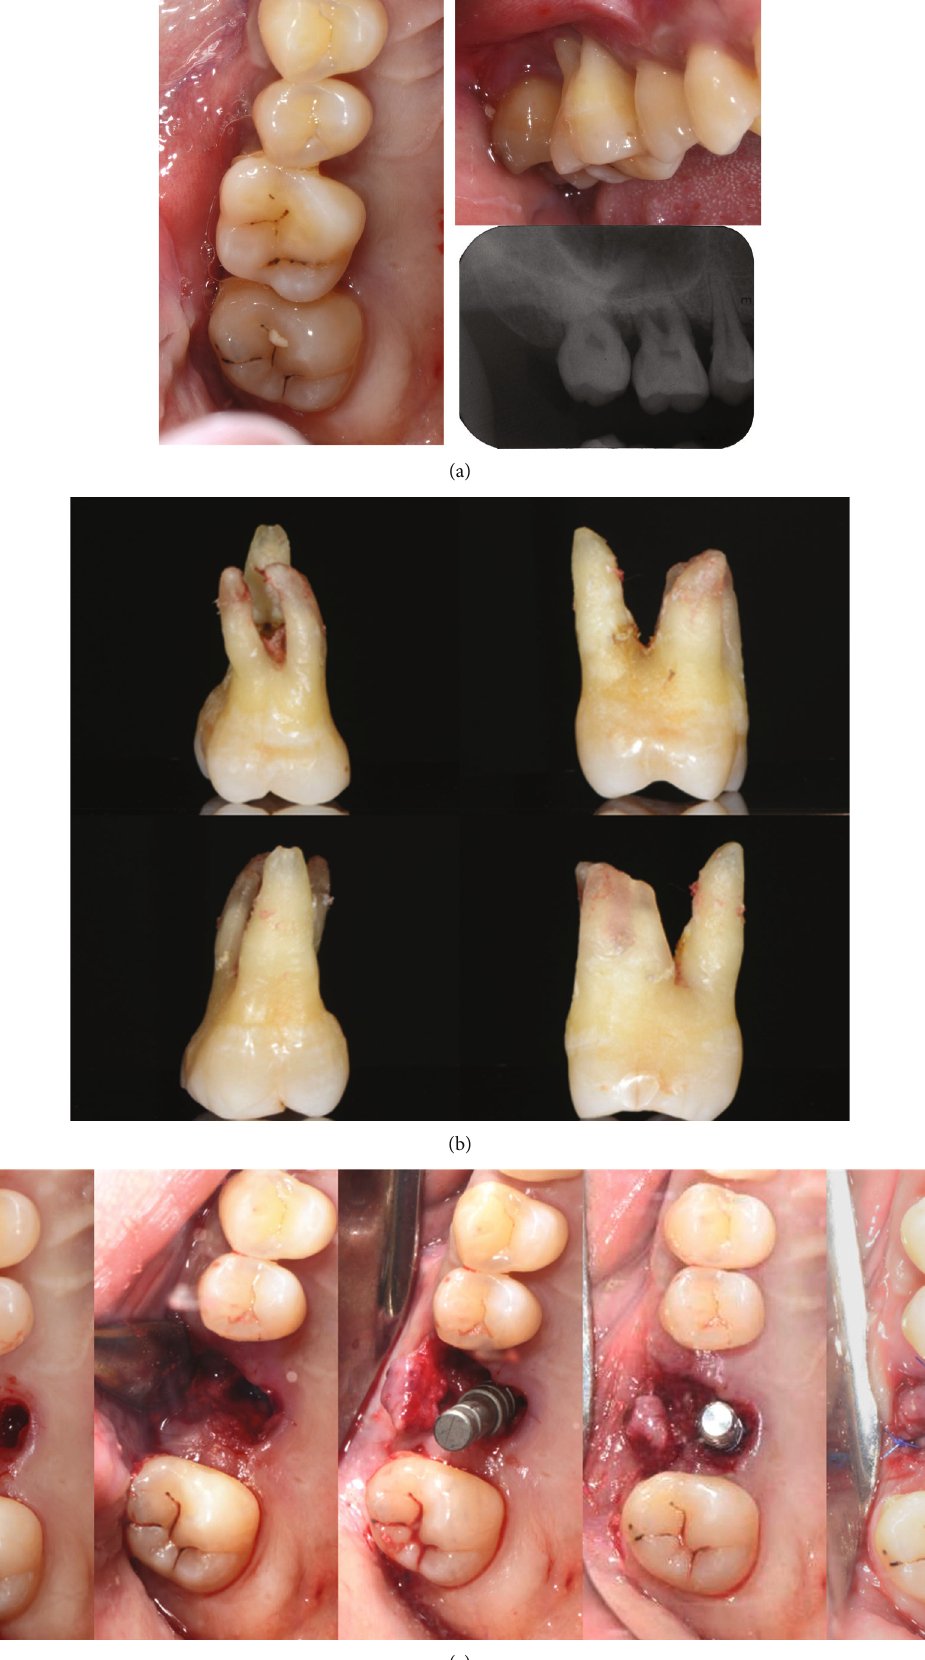
Figure 5: The process of implant placement. (a) Before the extraction. (b) The extracted teeth. (c) Immediate placement of